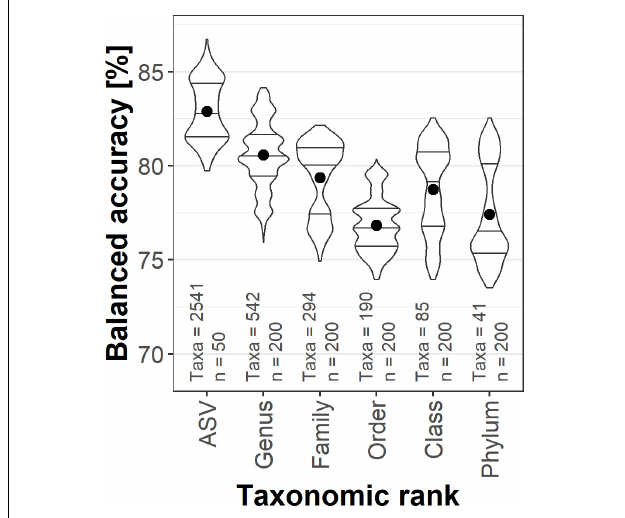
FIGURE 1 | Violin plots with median and interquartile range of correct TNT classifications of the validation set. The relative abundances were agglomerated on the taxonomic ranks. The dot represents the mean balanced accuracy; the classification results of the six different data set splits were averaged. n indicates the number of models calculated, Taxa represents the number of variables for each